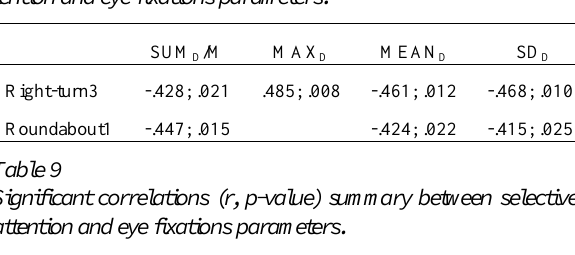
Significant correlations (r, p-value) summary between divided at- tention and eye fixations parameters.